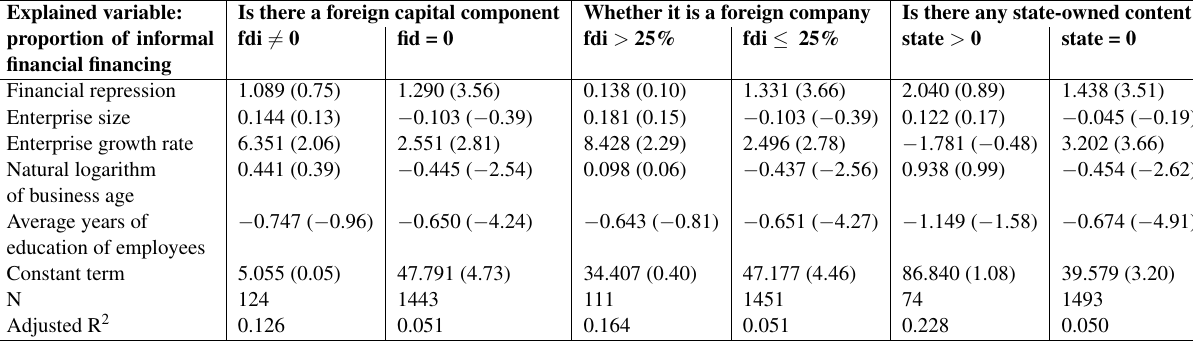
Table 1 Regression results of samples by ownership